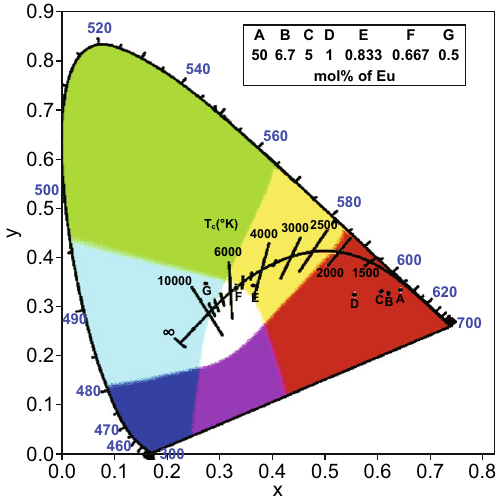
Fig. 22 CIE chromaticity diagram of mixed Eu x Tb 1− x -MOFs with different Eu ratios and excitation wavelengths. Reprinted with per- mission from Ref. [60]. Copyright 2019,